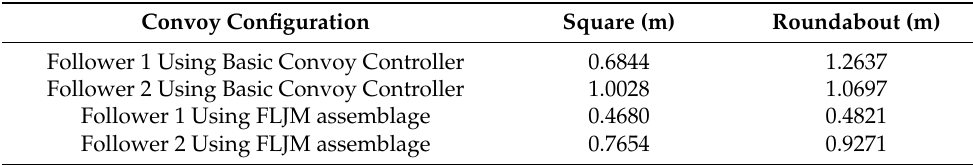
Table 4. Average MAE under a random jamming